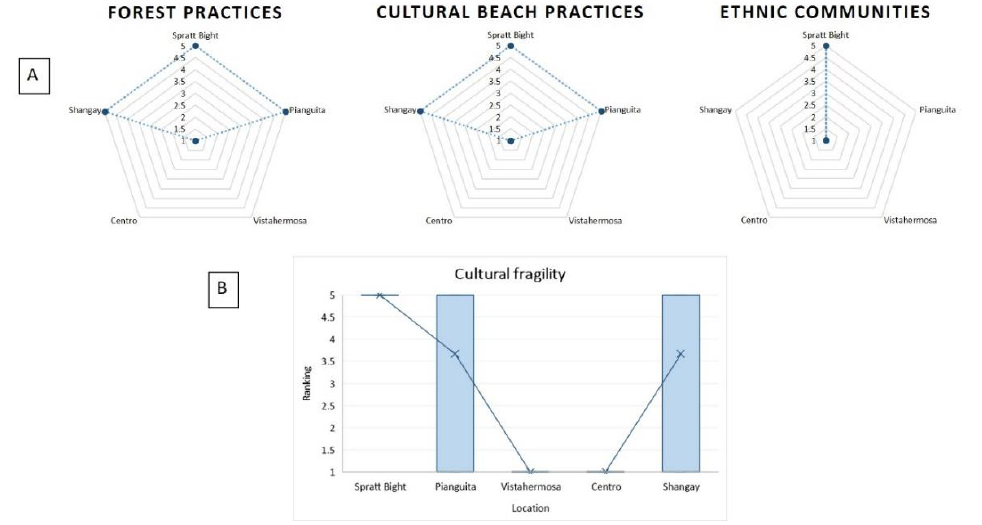
Figure 12. ( A ) Ranking of four variables representing cultural fragility for two study areas (and five villages): San Andrés, Caribbean Coast (Spratt Bight) and La Bocana, Pacific Coast (Pianguita, Vistahermosa, Centro, Shangay) of Colombia. ( B ) Minimum and maximum values of cultural fragility for each village and average rank. Results are shown by ranking, given that units of analysis are rank levels and not segments, as was the case for hazard.